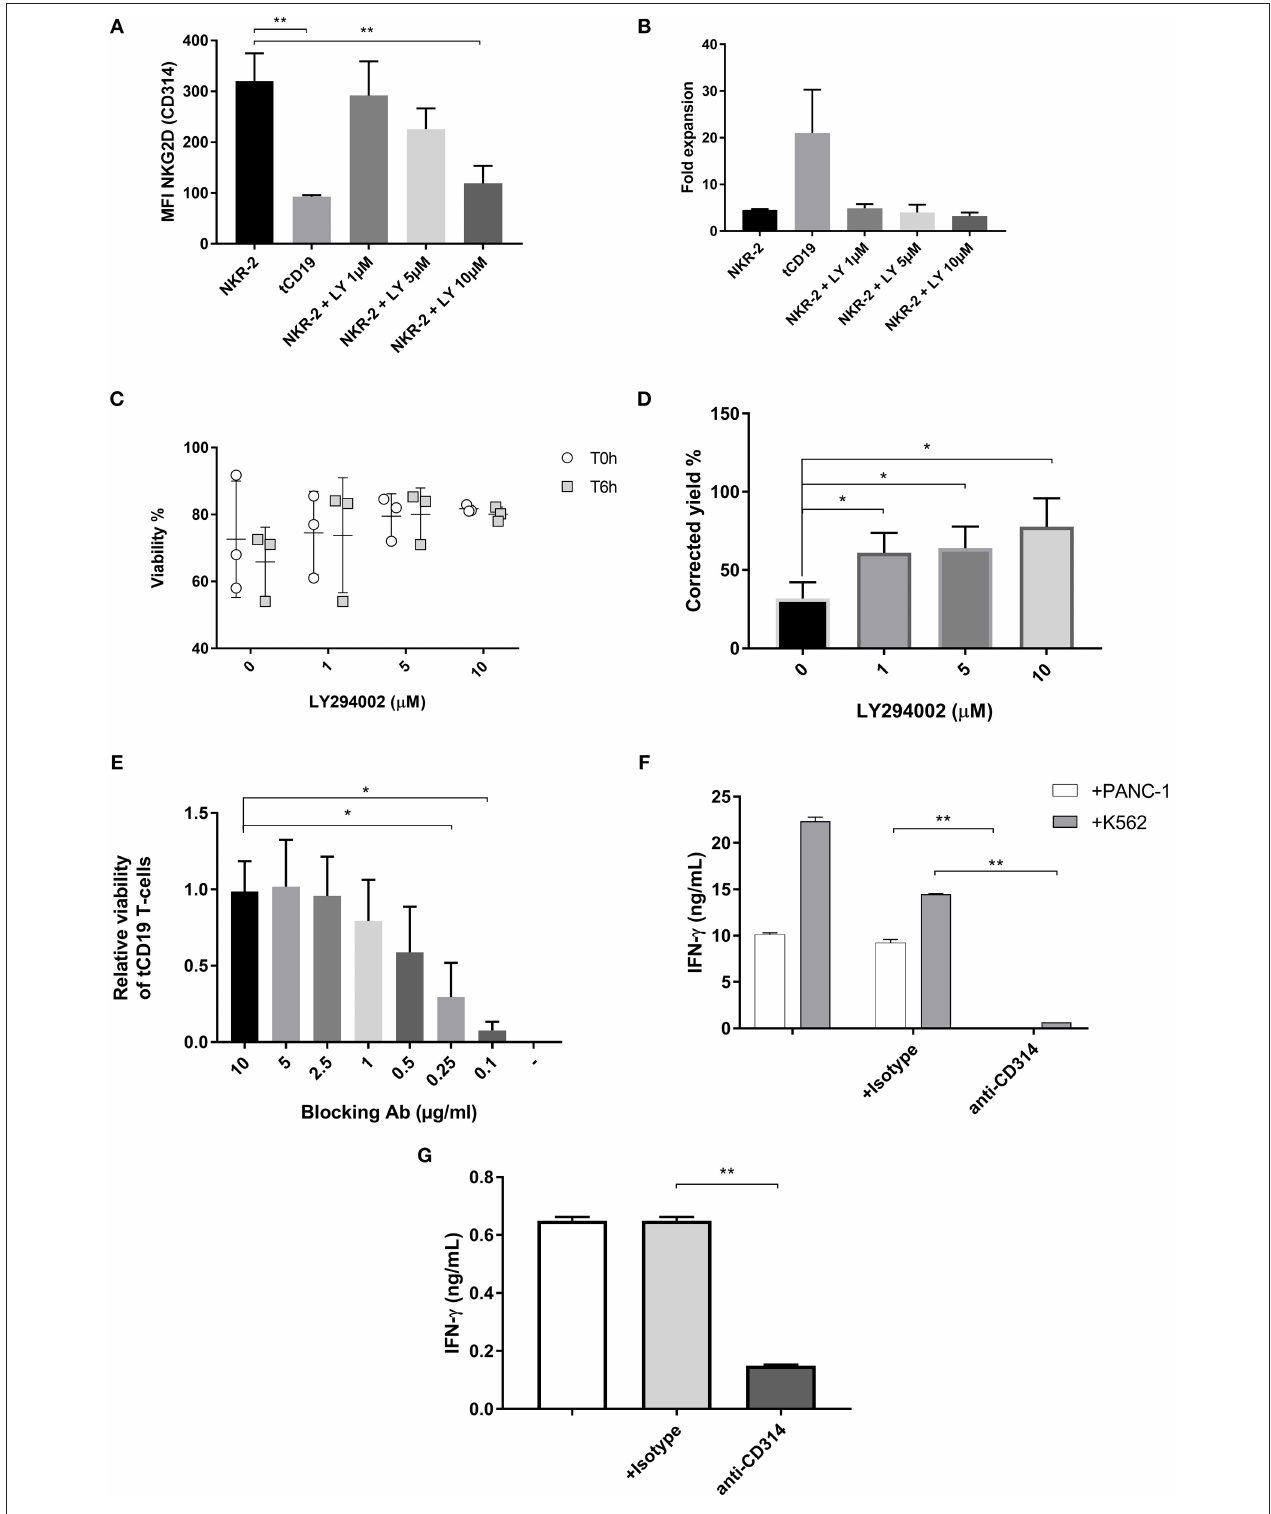
FIGURE 3 | NKR-2T cells fratricide is modulated by a PI3K inhibitor or a blocking antibody. (A) MFI of NKG2D expression on NKR-2T cells treated or not with increasing concentrations of LY294002. Data shown are mean ± SD of N = 3 independent donors. (B) Transduced T cells were cultured in complete X-vivo (100 IU/ml IL-2) supplemented or not with increasing concentrations of LY294002 for expansion. T cells were analyzed 96h after seeding for fold expansion relative to the